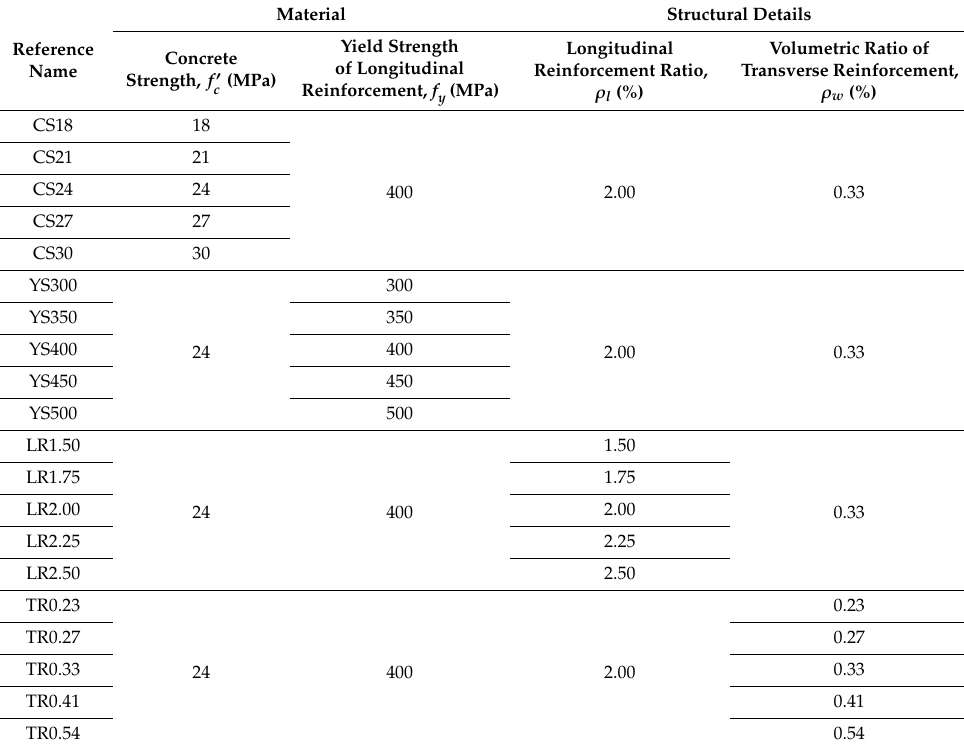
Table 1. Uncertainty of material properties and structural